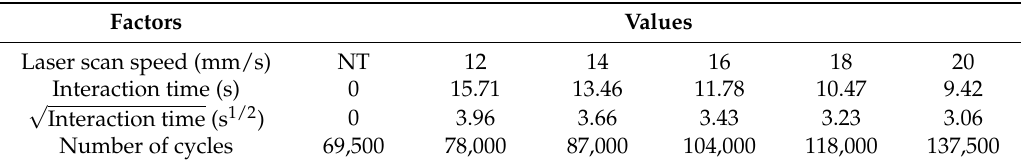
Figure 8. Laser path: AB and CD are characterized by a varying section, while BC has a constant section.